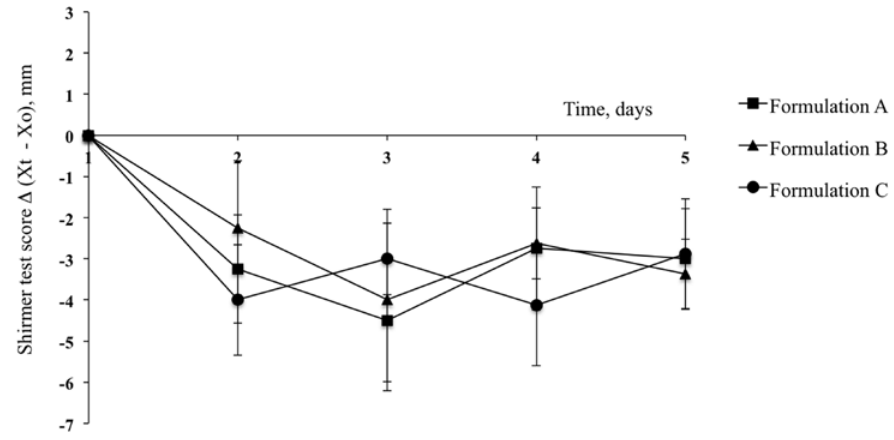
Figure 3. Shirmer Test Score for the contralateral eyes (Reference) after treatment with atropine sulphate aqueous solution (AS) for the different treatment groups. Means ± SE.